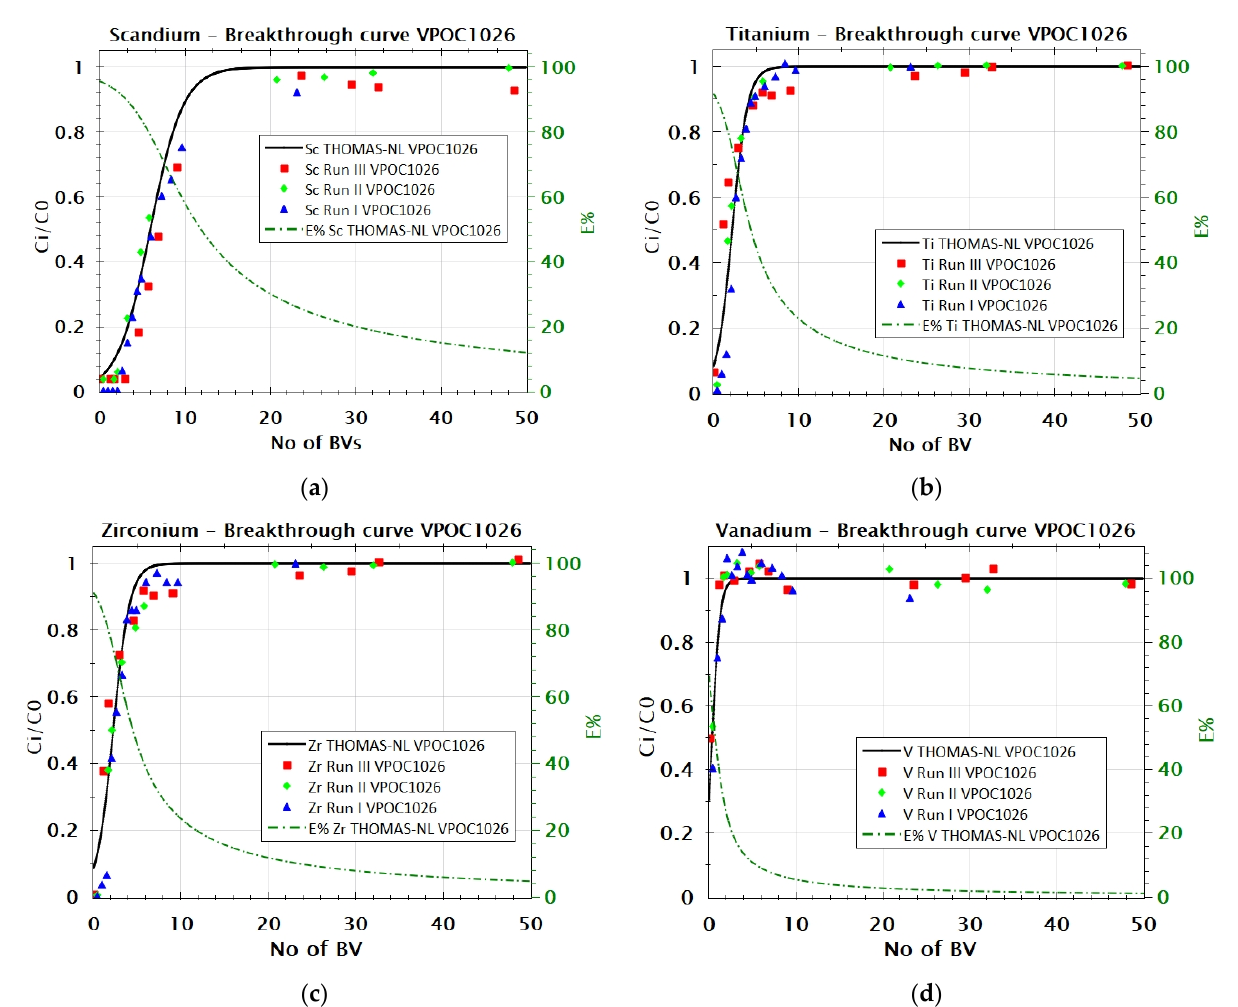
Figure 2. Extraction and breakthrough curves for VP OC 1026 resin for ( a ) Sc, ( b ) Ti, ( c ) Zr, and ( d ) V were measured in three different experimental runs and their Thomas nonlinear (NL) prediction mathematical